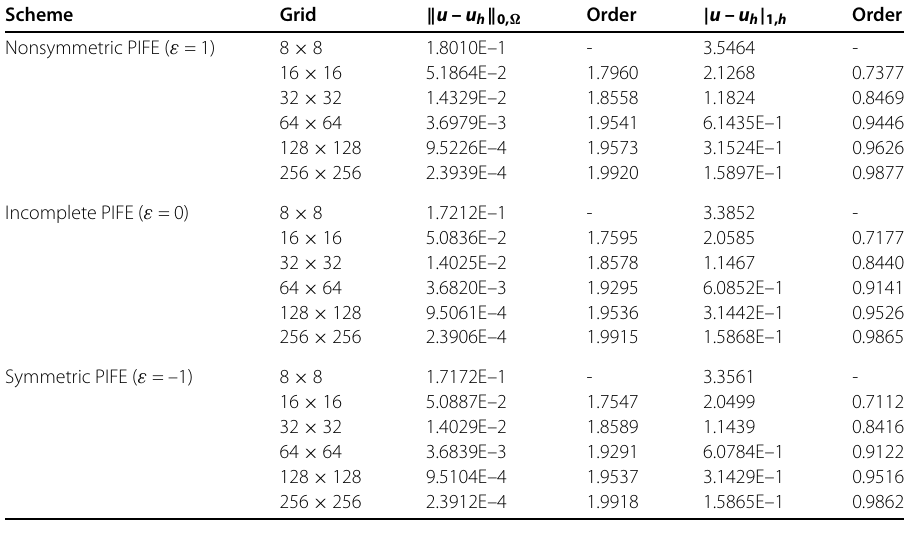
Table 4 Numerical results for B + = [10,20;20,50], B – = [1,2;2,5]